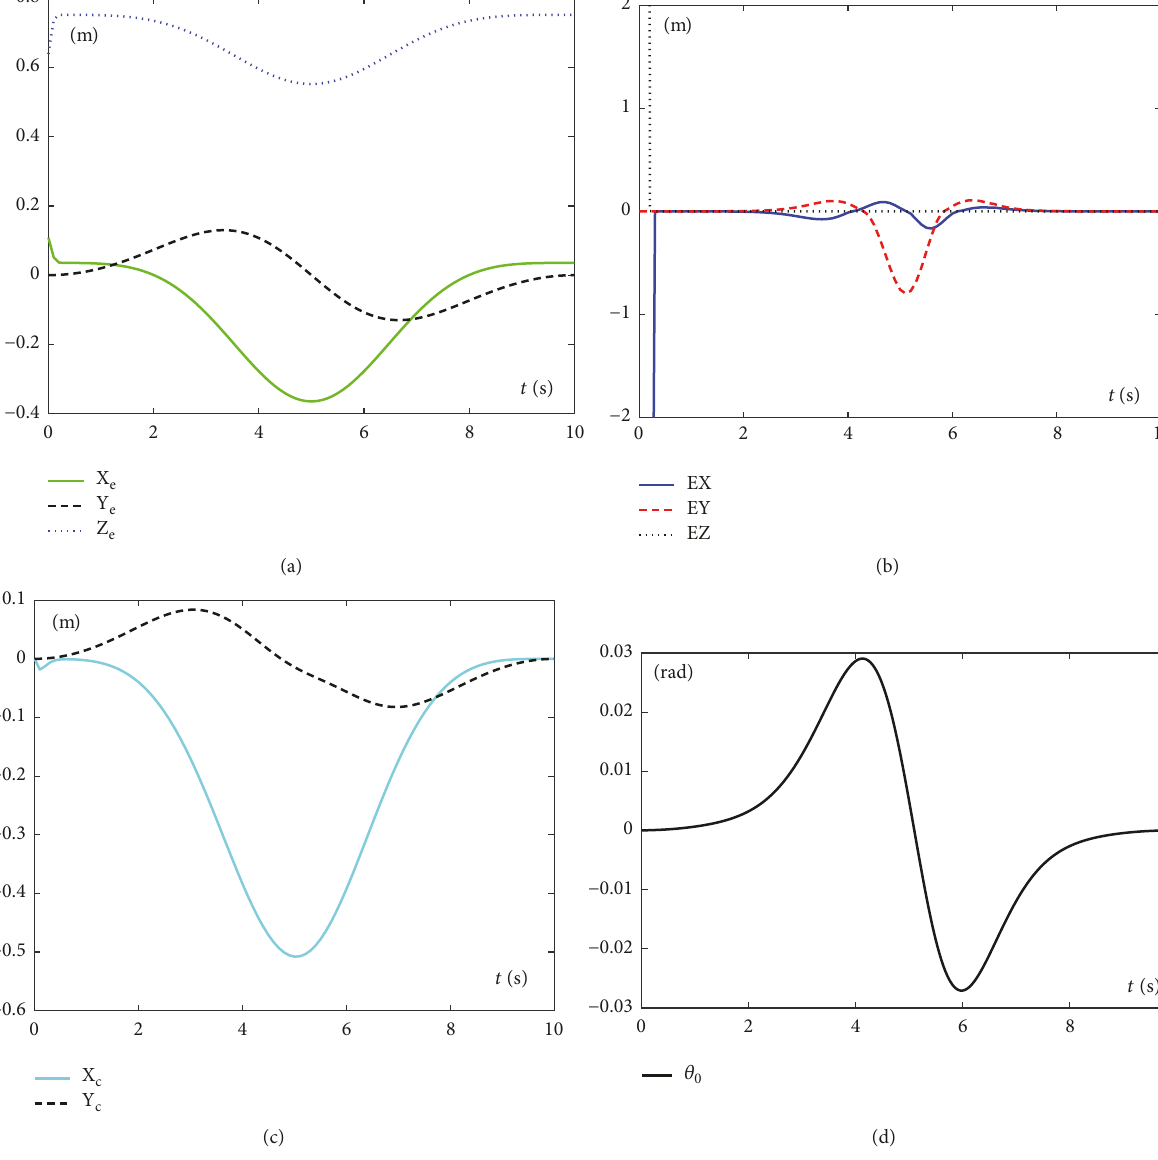
Figure 6: Circular planning profiles of the three-wheel mobile manipulator synthesized by TTZNN model (27). (a) Position files of the end- effector. (b) Position error of the end-effector in three dimensions. (c) Profiles of the mobile base for 𝑃 𝐶 . (d) Trajectory with heading angle 𝜃 0